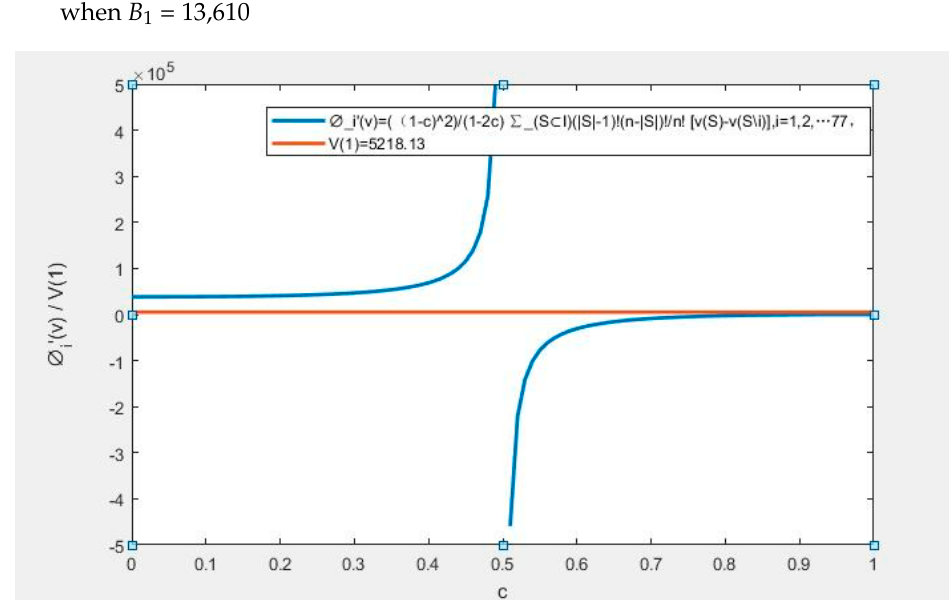
Figure 2. The improved Shapley value of China as an